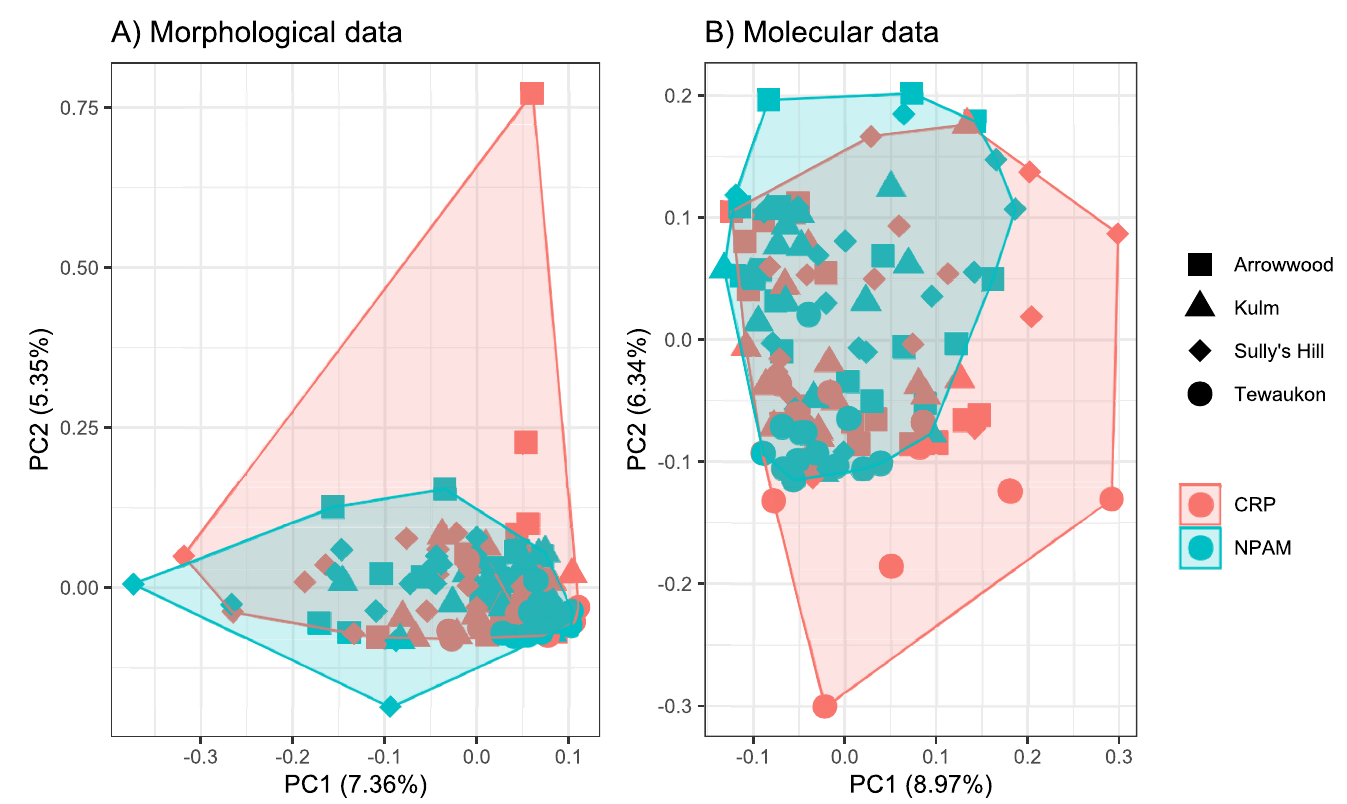
Fig 8. Ordination of Principal Components Analysis. Bee samples from Conservation Reserve Program (CRP) and Native Prairie Adaptive Management (NPAM) grassland types across four locations (Arrowwood, Kulm, Sully’s Hill, Tewaukon) plotted along principal component 2 (vertical axis) and principal component 1 (horizontal axis) based on A) morphological specimen identification, or B) molecular 28S LSU sequencing. The shaded region represents the minimum convex polygon encompassing all samples and all locations for a given management regime.